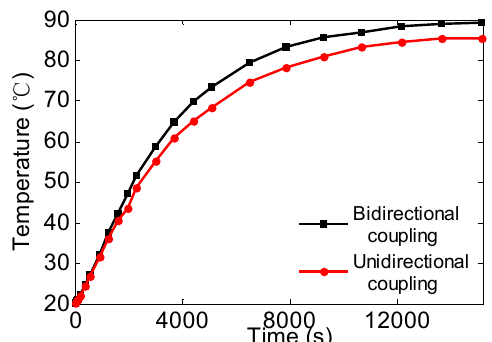
Figure 18. The temperature rise of the magnet.